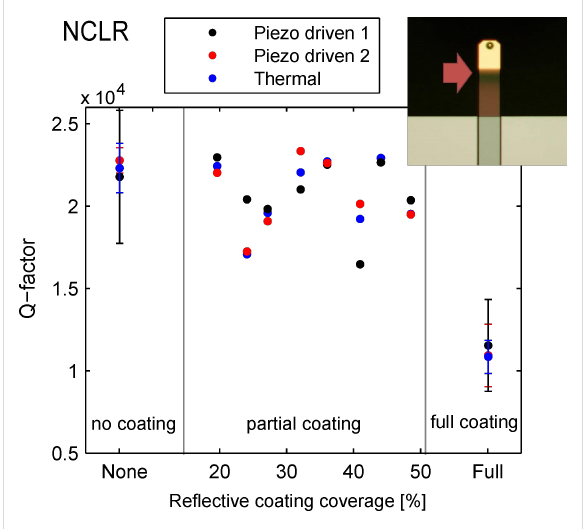
Figure 1: Q -factor of NCLR cantilever with different coating coverage percentages. A 30 nm Al coating was added on the 7 μ m thick cantilever. 20% coating coverage show the same Q -factor as uncoated cantilever. The errorbars show standard deviation of the mean of at least 3 different